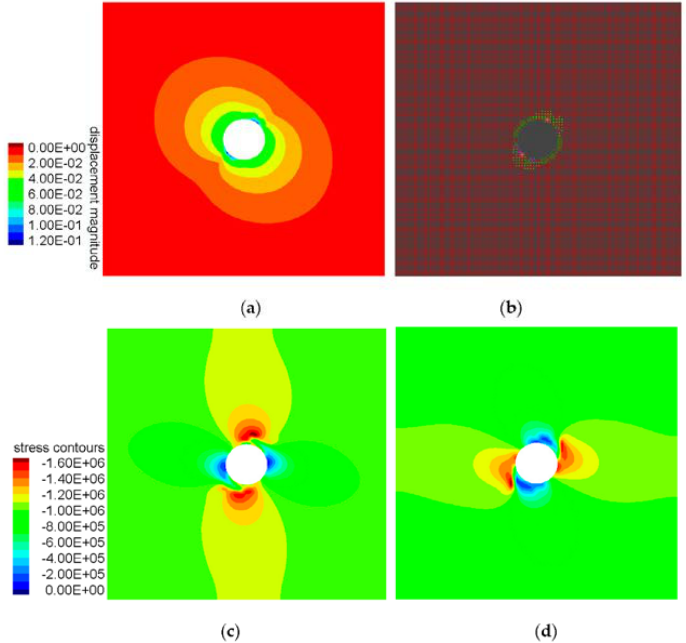
Figure 20. Simulation results for tunnel model with joint orientation of − 60° and κ = 1: ( a ) displacement contours [m], ( b ) plasticity state, ( c ) contour plot of horizontal stresses [Pa] and ( d ) contour plot of vertical stresses [Pa].